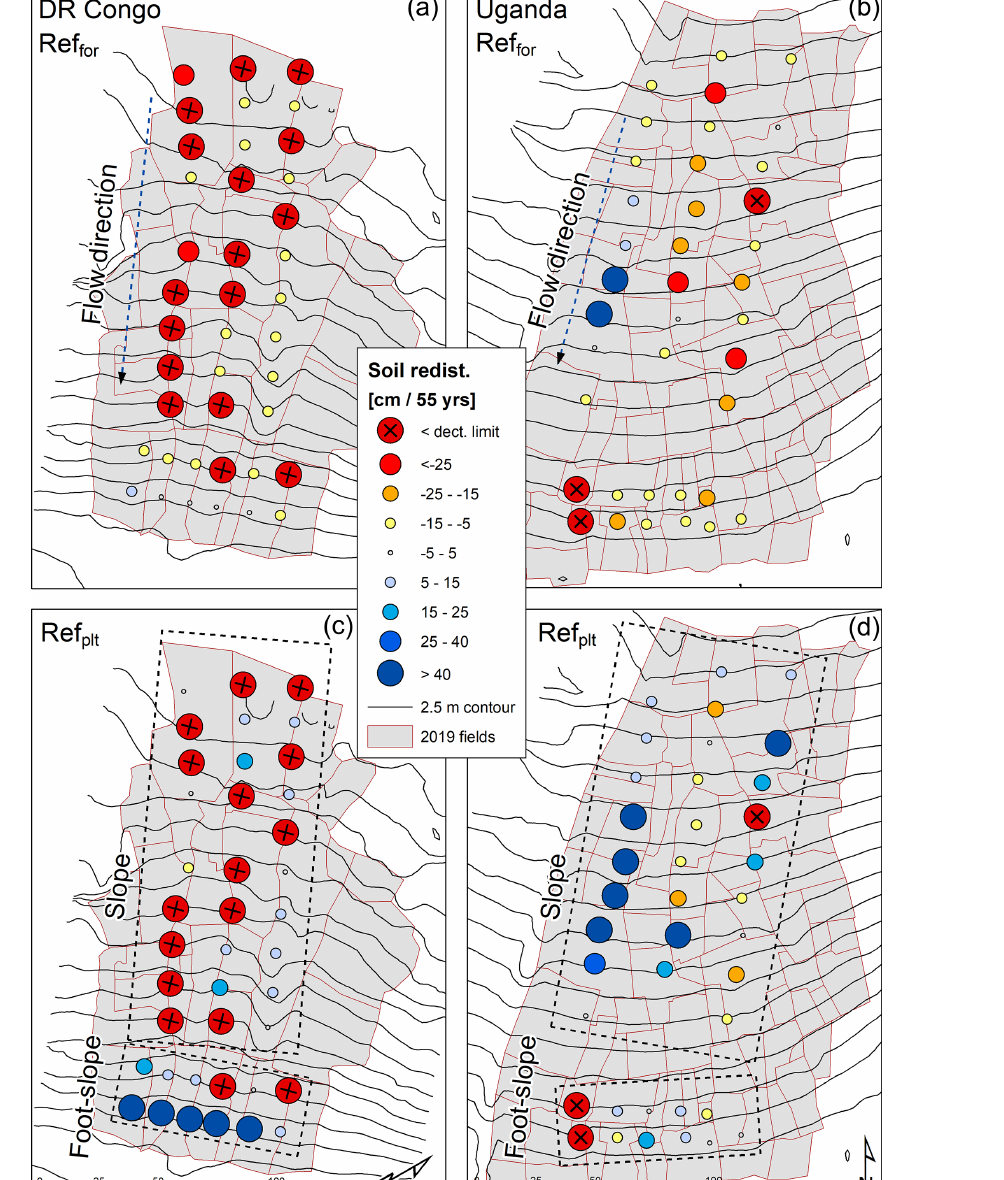
Figure 5. Soil redistribution derived from 239 + 240 Pu measurements using a mass balance model. Two different reference inventories ( a, b Ref for mean forest reference; c, d Ref plt mean cropland plateau reference) in two cropland areas of the White Nile-Congo rift re- gion ( a, c DR Congo; b, d Uganda) were used for